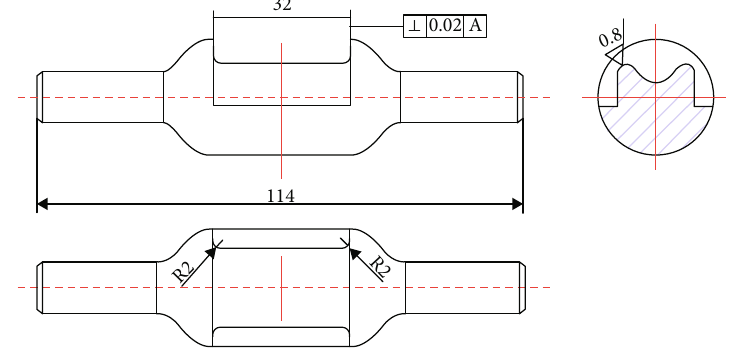
Figure 7: Using electrodes 701 to machine the transition segments in immersion oil.